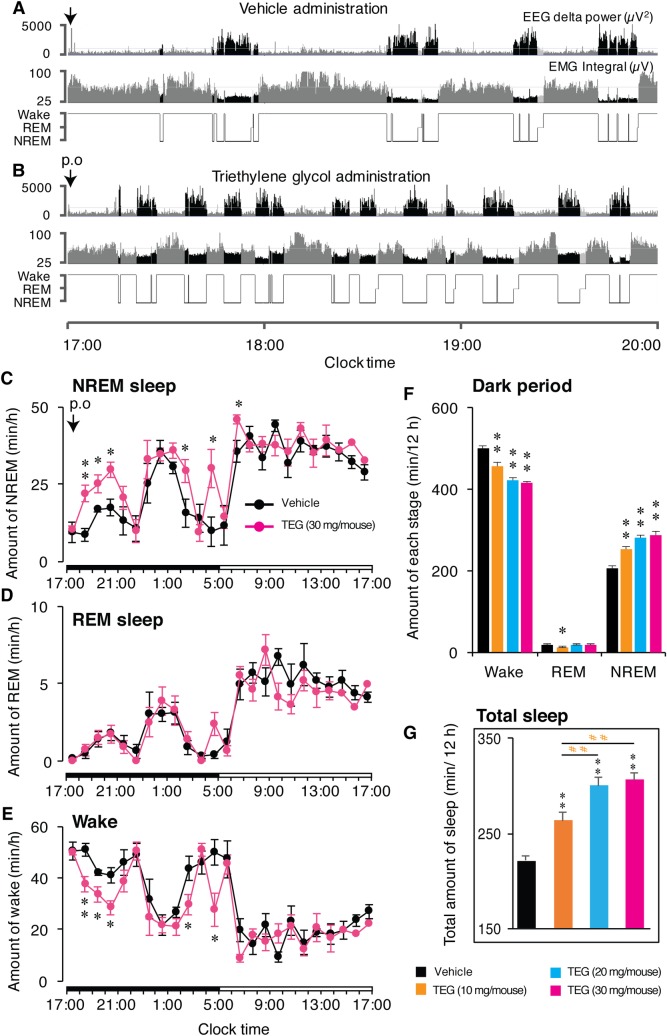
Dose-dependent increase in NREM sleep and decrease in wakefulness by p.o. administration of TEG in mice.(A, B) Typical examples of EEG delta power (0.5–4 Hz), EMG integral, and hypnograms of a mouse after p.o. administration of vehicle (A) or TEG (B). Hypnograms represent concatenated 10-sec epochs of EEG/EMG activity, scored as wake, REM, and NREM sleep. Three hours after p.o. administration are shown. Wake, REM are shown in gray while NREM sleep shown in black. (C, D and E) Hourly plots of NREM, (C), REM sleep (D) and wake (E) in mice after p.o. administration of vehicle (black circles) and TEG (30 mg/mouse; magenta circles). Significant increase in NREM sleep and decrease in wake are apparent in the graphs at least up to 4 h after TEG administration. Black and white horizontal bars indicate 12 h dark and 12 h light period. (F) Total amount of wake, REM, and NREM sleep over 12 h dark period after vehicle (black bars) and various doses of TEG (colored bars) administration. There was a dose-dependent increase in NREM sleep with concomitant decrease in wake. (G) Graph shows total amount of sleep during dark phase (12 h) following vehicle (black bar) and various doses of TEG (color bars) administration. All administrations were done at the onset of dark period (17:00 h). Data presented as mean ± SEM; n = 6; *p≤0.05, **p≤0.01 vs vehicle by using paired t-test for time course data (C, D and E), and one-way ANOVA followed by least square difference (LSD) post-hoc test for dose-response data (F and G). # #p≤0.01 vs TEG (10 mg/head).